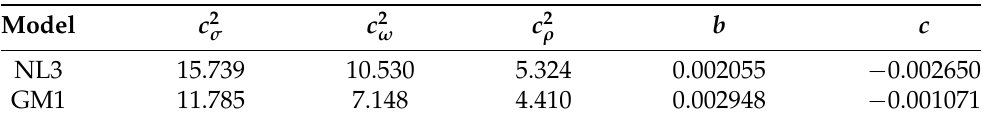
Table 1. Parameter sets for the NL3 and GM1 models. The nucleon-meson coupling constants c 2 σ , c 2 ω , and c 2 ρ are expressed in fm 2 , while b and c are dimensionless [58].